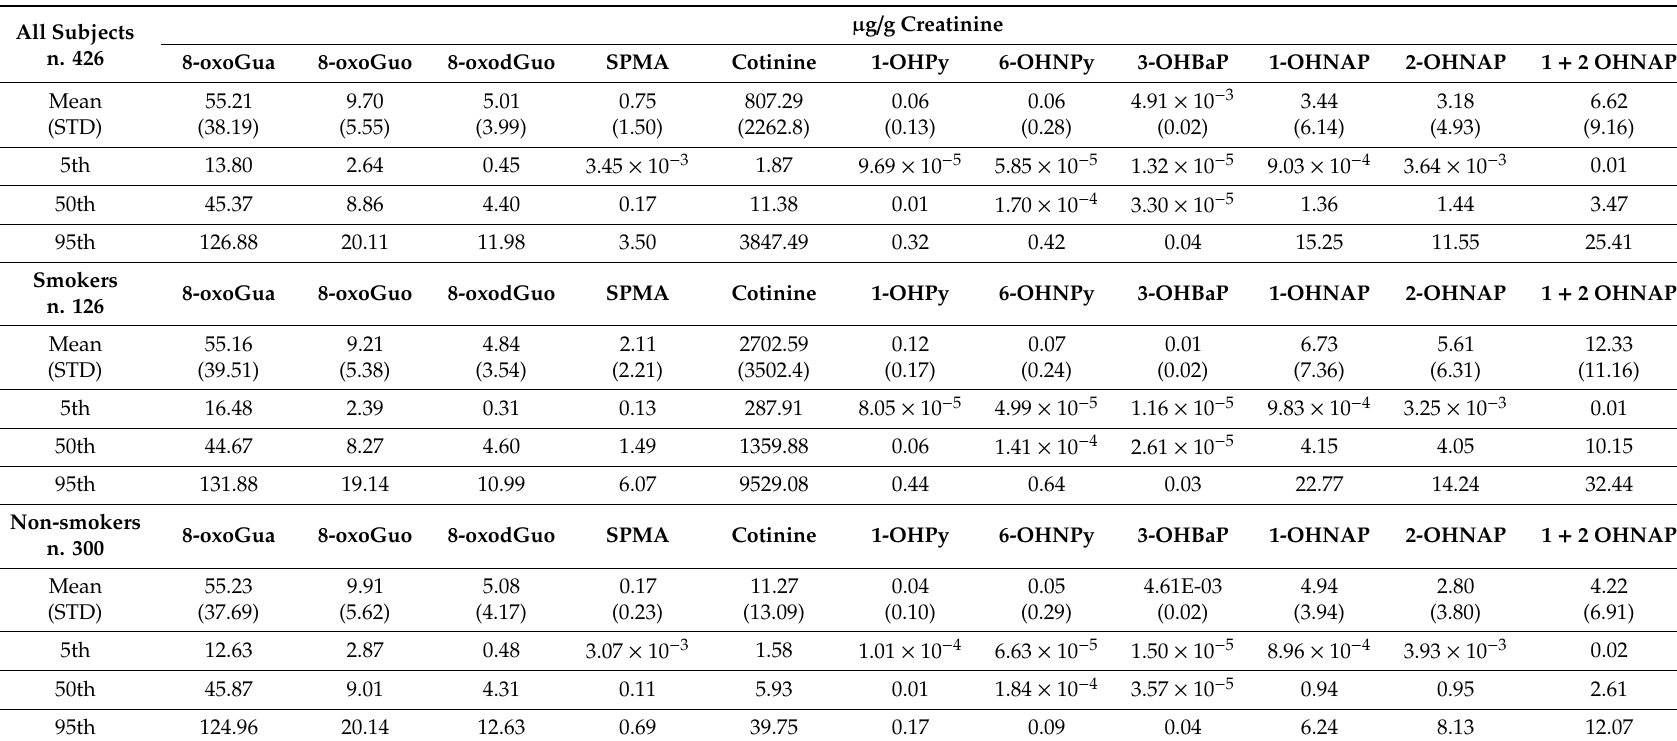
Table 2. Urinary concentrations of 10 biomarkers in subgroup of 426 subjects, in smokers and